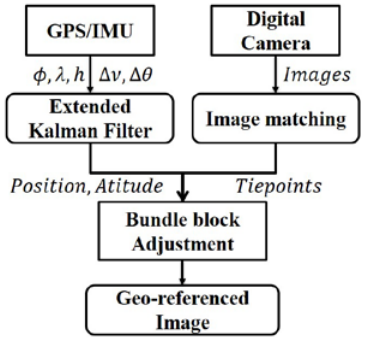
Figure 6. Processing flow in georeferencing